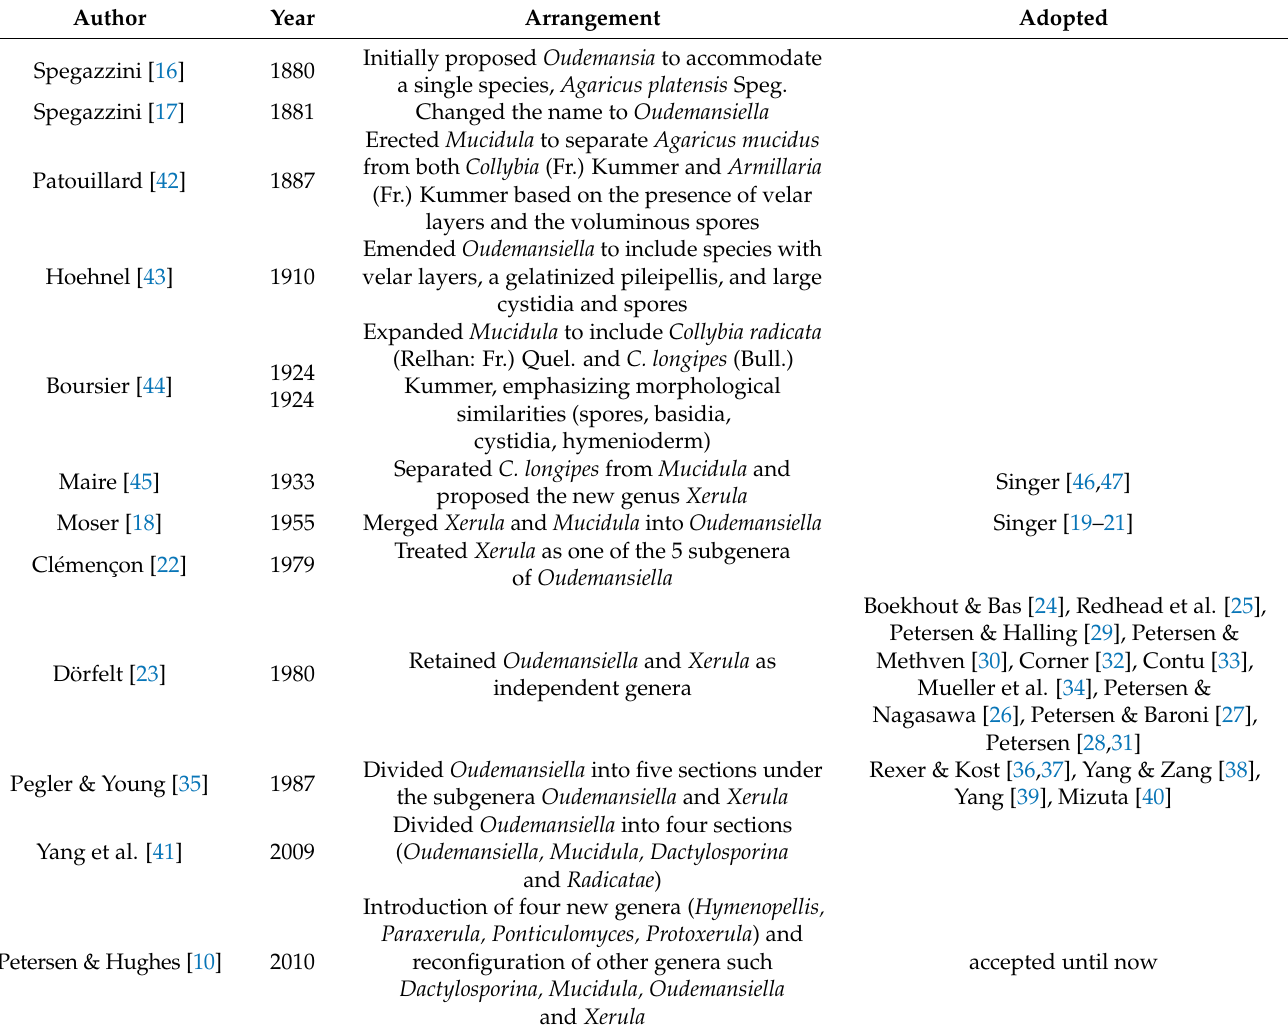
Table 1. History of taxonomic placements of oudemansielloid/xeruloid (OX)